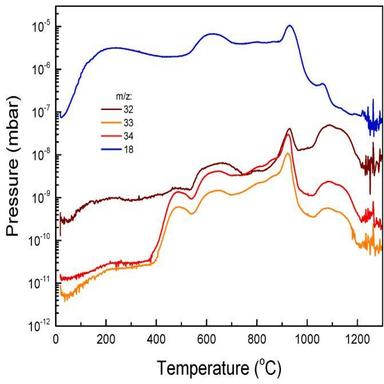
H2S signature, deduced from the m/z = 34 (red line) and m/z = 33 peaks (orange line); m/z = 32 (brown line) carries multiple other contributions. The m/z = 18 water peak (blue line) is shown for scale. (For interpretation of the references to color in this figure legend, the reader is referred to the Web version of this article.)